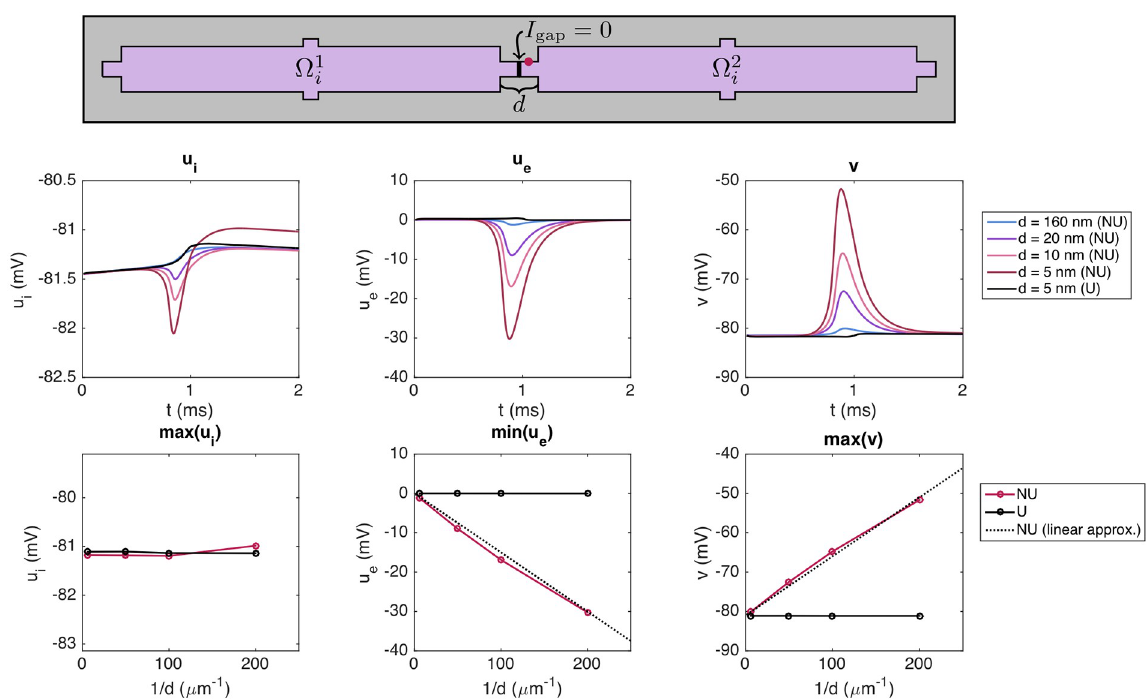
Fig 14. The extracellular potential between cells is highly affected by the cell distance for the NU case. The figure shows the intracellular potential, the extracellular potential and the membrane potential observed after blocked gap junctions for different values of the cell distance, d . The distance d is the combined length of O W and O E (see Fig 2 and the upper panel of this figure). In the NU case, we distribute all sodium channels on the vertical part of the cell ends (see Fig 3C). We consider two cells with gap junction conductance G the first half of the first cell. The potentials are recorded in a grid point located just after the blocked gap junctions, on the membrane of the second cell, illustrated by a red circle in the upper panel. The parameter values used in the simulations are given in Table 1, except that we use Δ t = 0.01 ms, Δ z = 1 μ m and a slightly reduced cell size. We let O O be of size 100 μ m × 12 μ m × 12 μ m, O W and O E be of size d /2 × 4 μ m × 4 μ m and O S and O N be of size 4 μ m × 2 μ m × 4 μ m. Furthermore, we use Δ x = d /4. The center panel shows the intracellular potential, the extracellular potential and the membrane potential as functions of time. The lower panel shows the maximum intracellular potential, the minimum extracellular potential and the maximum membrane potential as functions of 1/ d